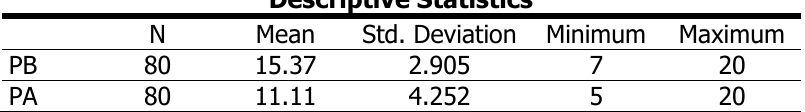
Table 1. Descriptive Statistics of Physical Motivation Descriptive Statistics